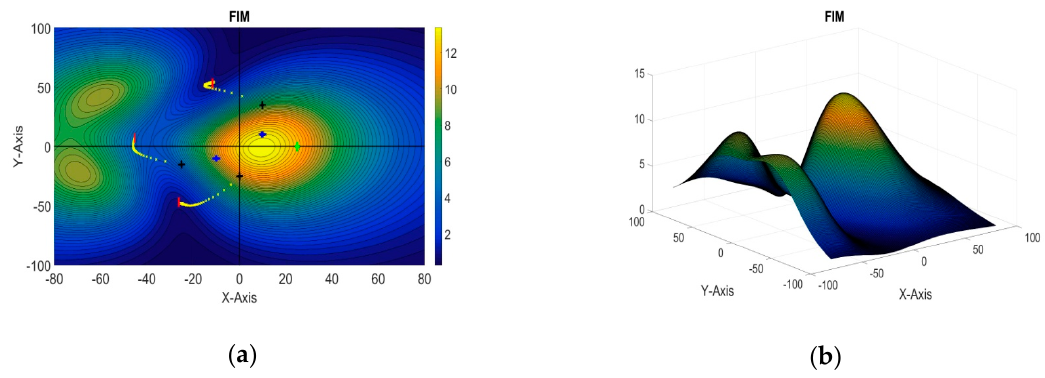
Figure 6. ( a ) 2D contour plot of the evaluation function (3 + 1 sensors, two targets); ( b ) 3D plot of the evaluation function (3 + 1 sensors, two targets). Table 4. Optimal Positions of Sensor AUVs (Various Sensor–Target